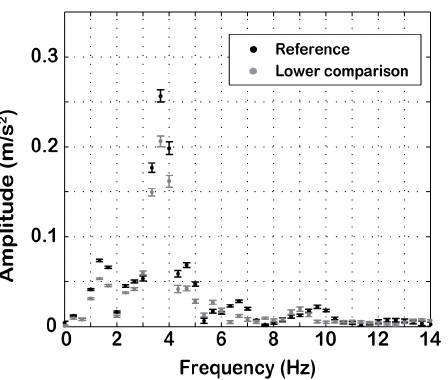
Figure 3. Amplitude-frequency spectrum. Example of an ampli- tude-frequency spectrum for a reference of 1.6 m/s 2 and corresponding lower comparison. In this example the simulator noise mainly affects frequencies around 4 Hz. Error bars represent standard deviations of the 20 repetitions of each profile. The abscissa is limited to only the first 61 frequency components (0–20 Hz) out of the 241 (0–80 Hz) used for the analysis for better graphical clarity.